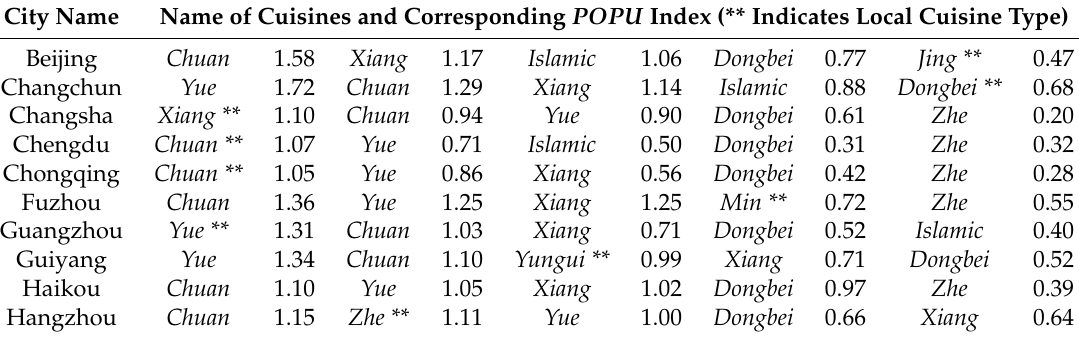
Table 3. Popularity index ( POPU ) of top five regional Chinese cuisines in the 31